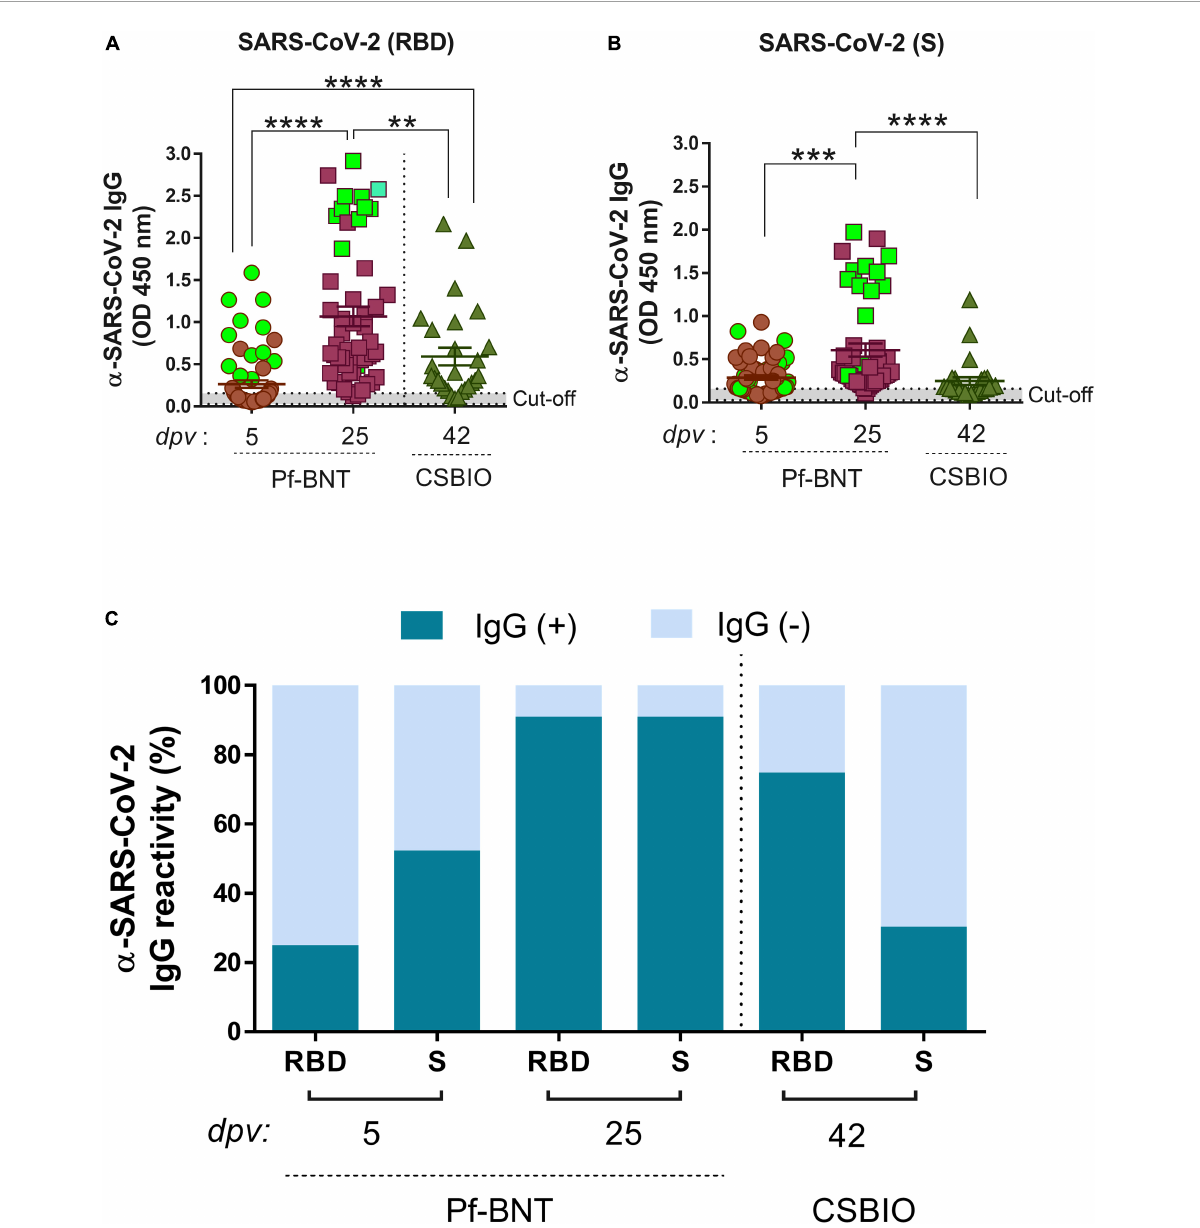
FIGURE1 IgG-specific responses to the RBD, S, and N proteins of SARS-CoV-2 in two groups of vaccinees. IgG levels expressed as OD values against RBD (A) , and S (B) , proteins determined from positive and negative serum samples [here expressed as IgG reactivity % ( y -axis)] based on previously established cut-off values > 0.20 (horizontal dotted line and gray zone ) (C) . Serum samples for Pf-BNT and CSBIO vaccinees were collected after 5 ( n = 62) and 25 ( n = 51), and 43 ( n = 27) dpv, respectively [vaccine values separated by vertical dotted line ( x -axis)]. Mann–Whitney test: **** p < 0.0001; ** p < 0.001; * p < 0.05. n.s., non-significant differences. (A,B) Each group of data in the scatter plots represent absorbance values (OD) obtained from individual serum sample per vaccine group including the mean ± SEM (standard error) of individual groups. Participants with record of COVID-19 (PCR-positive test) before vaccination are highlighted in light green. (C) Stacked bars represent the percentage of serum samples per vaccine group showing IgG positive (+, green ) or negative (–, light blue ) OD values against individual SARS-CoV-2 viral targets. dpv, days post-vaccination.